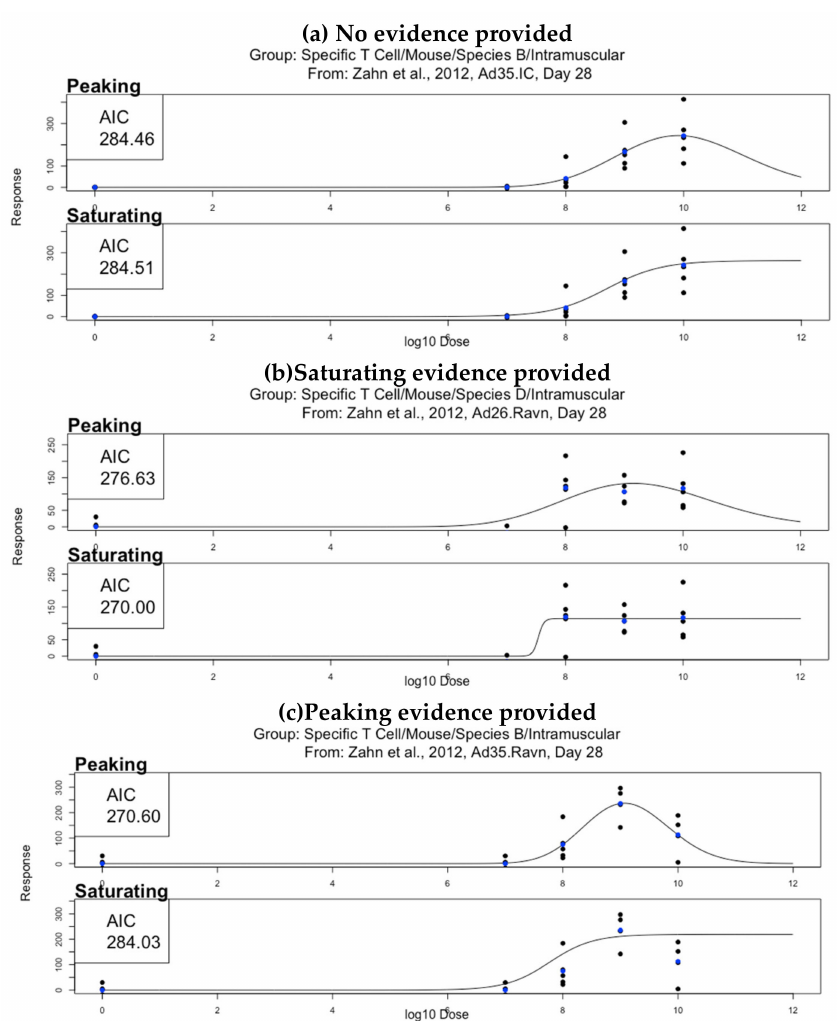
Figure 2. An example of three datasets; ( a ) does not provide evidence to support one curve shape over the other (i.e., ∆ AIC = 0.05 < 2), ( b ) provides evidence to support a saturating curve shape over a peaking curve shape (i.e., ∆ AIC = 6.63 > 2), and ( c ) provides evidence to support a peaking curve shape over a saturating curve shape (i.e., ∆ AIC = 13.43 > 2). For each dataset, the top plot shows the calibrated peaking curve and associated Akaike Information Criterion (AIC), and the bottom plot shows the calibrated saturating curve and associated AIC. Black dots represent individual mice and blue dots represent the mean response for that